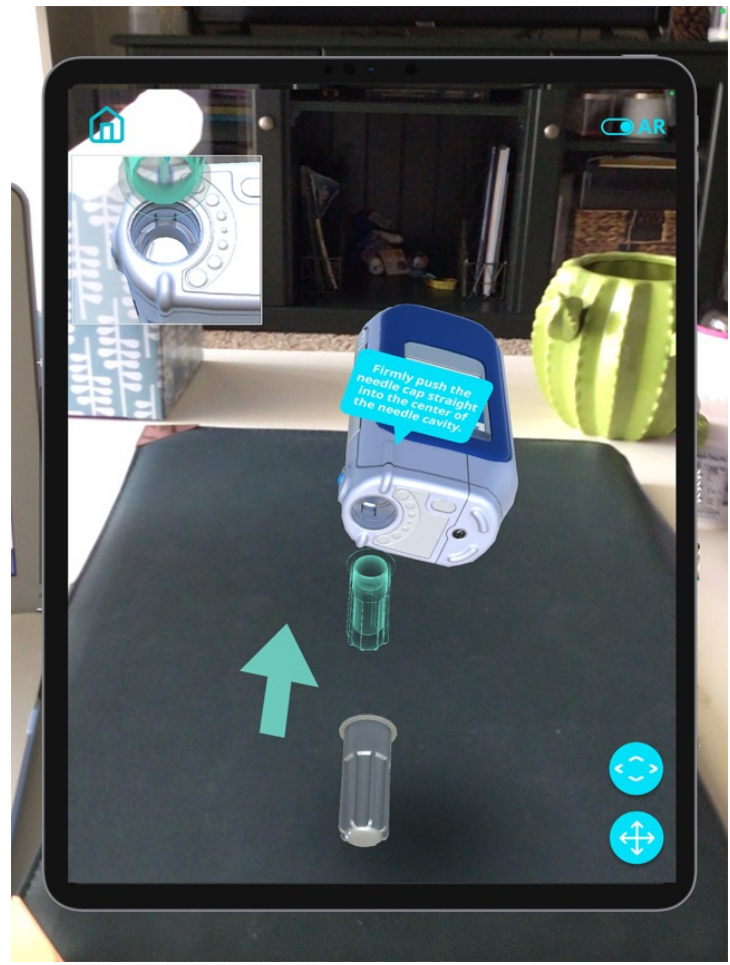
Figure 3. Easypod ® augmented reality (Merck KGaA, Darmstadt, Germany). Augmented reality is used to train caregivers and patients to load a growth hormone filled cartridge into the Easypod growth hormone injection device, with permission form [54].